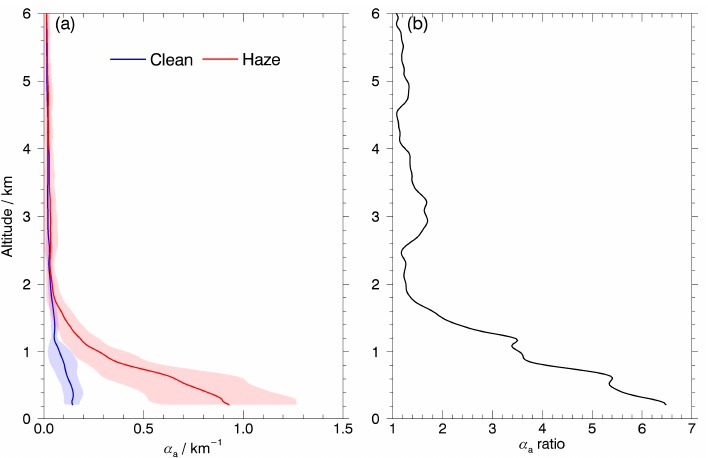
Figure 7. ( a ) Average α a profiles during the clear (blue) and haze (red) periods, respectively. The shaded areas indicate the standard deviations. ( b ) The ratio profile of average α a during the haze to the clear period.